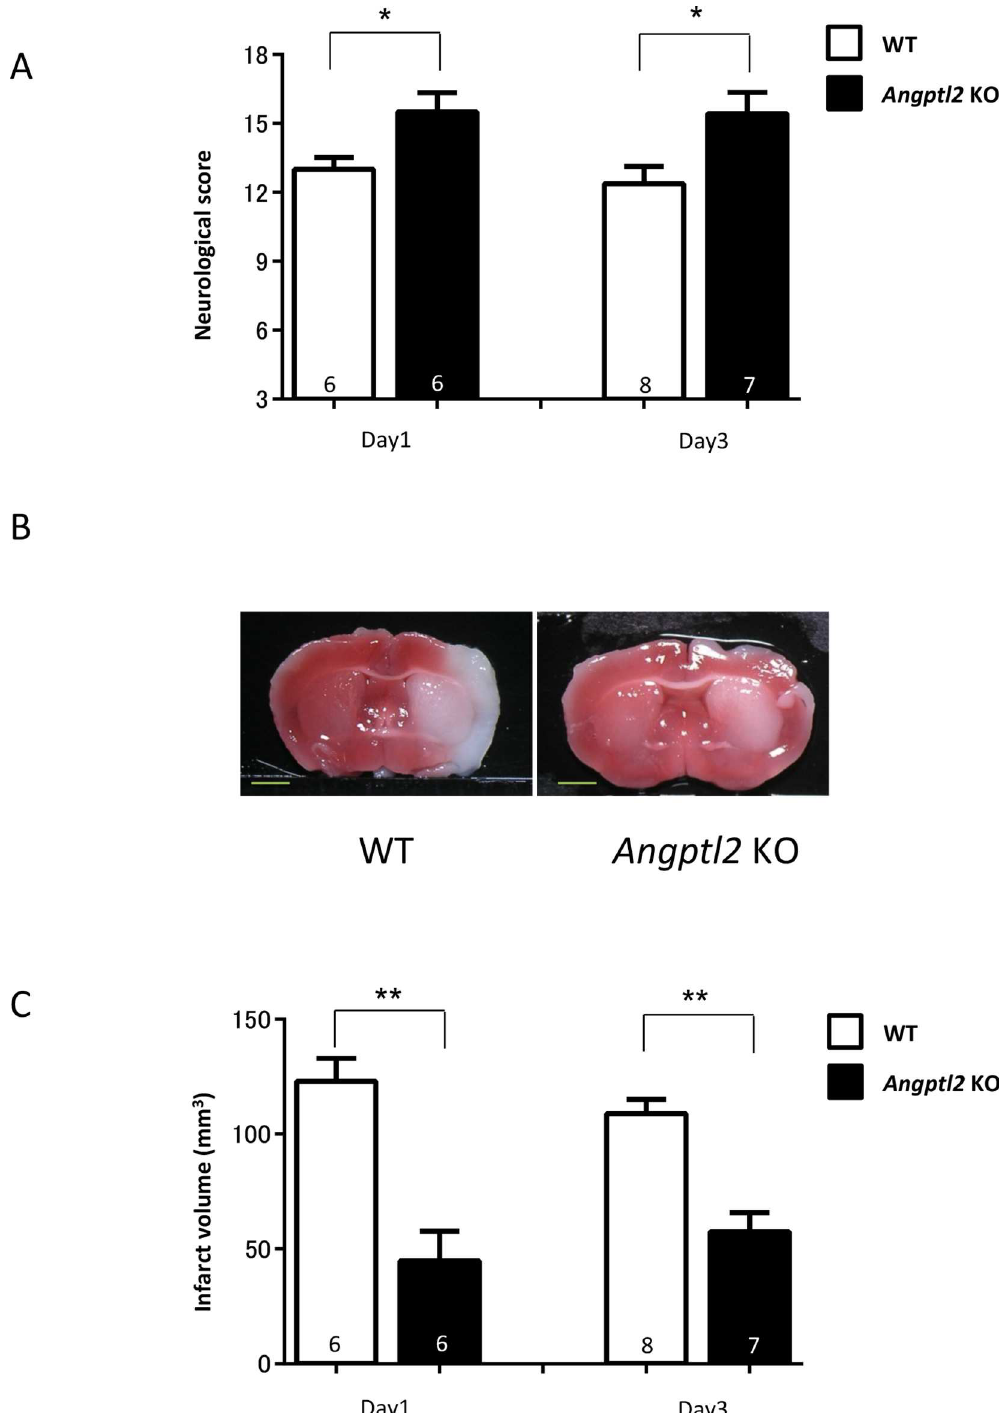
Fig 2. Ischemic injury is attenuated in the brain of Angptl2 -deficient mice in a mouse transient MCAO model. ( A ) Neurological scores assessed24 and 72 hours after transient MCAO (day 1: WT = 6 and KO = 6; day 3: WT = 8 and KO = 7) (Garcia scale, S3 Appendix).Results are expressedas means ± s.e.m. ( B ) Representative triphenyltetrazolium chloride(TTC)-stained coronal sections from ischemic brain 24 hours after transient MCAO. Scale bars: 2mm. ( C ) Infarct volume as measuredby TTC-staining of serial coronal sections 24 and 72 hours after transient MCAO (day 1: WT = 6 and KO = 6; day 3: WT = 8 and KO = 7). Results are expressedas means ± s.e.m. * P < 0.05, ** P <